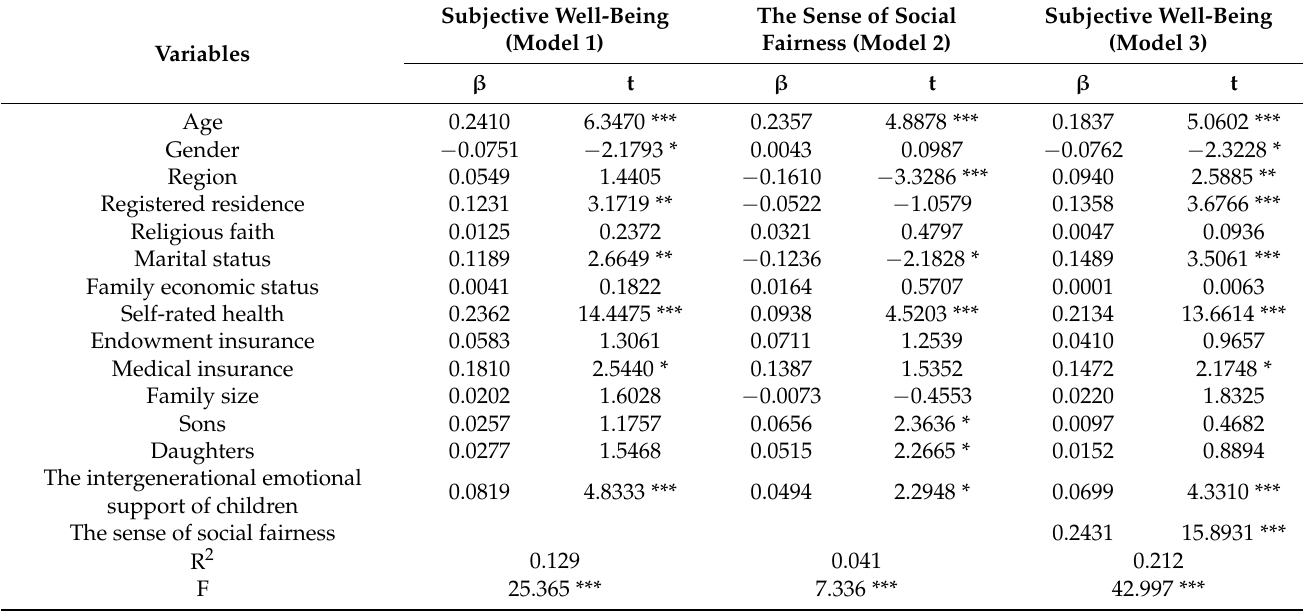
Table 3. Mediating model testing of the sense of social